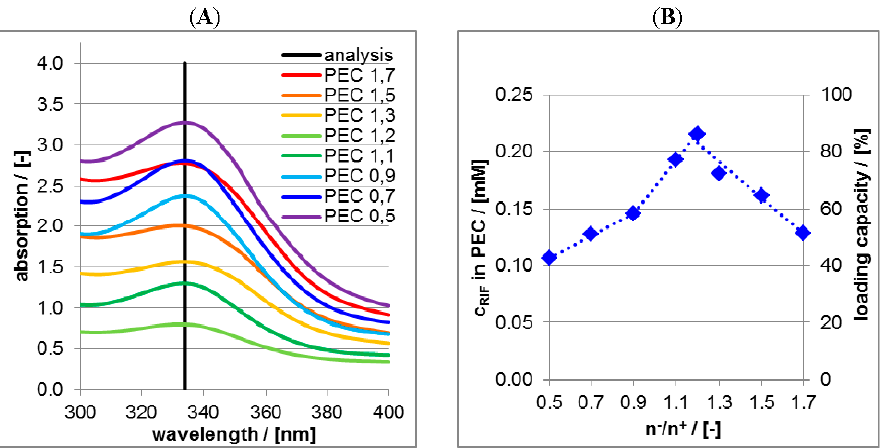
Figure 7. ( A ) UV/VIS spectra of supernatant after centrifugation of RIF-loaded PEC dispersions at pH = 2 for various molar mixing ratios n − /n + ; ( B ) Plot of the concentrations (left ordinate axis) and of the loading capacity (right ordinate axis) of RIF in the PEC particles as a function of the molar mixing ratio n − /n + .